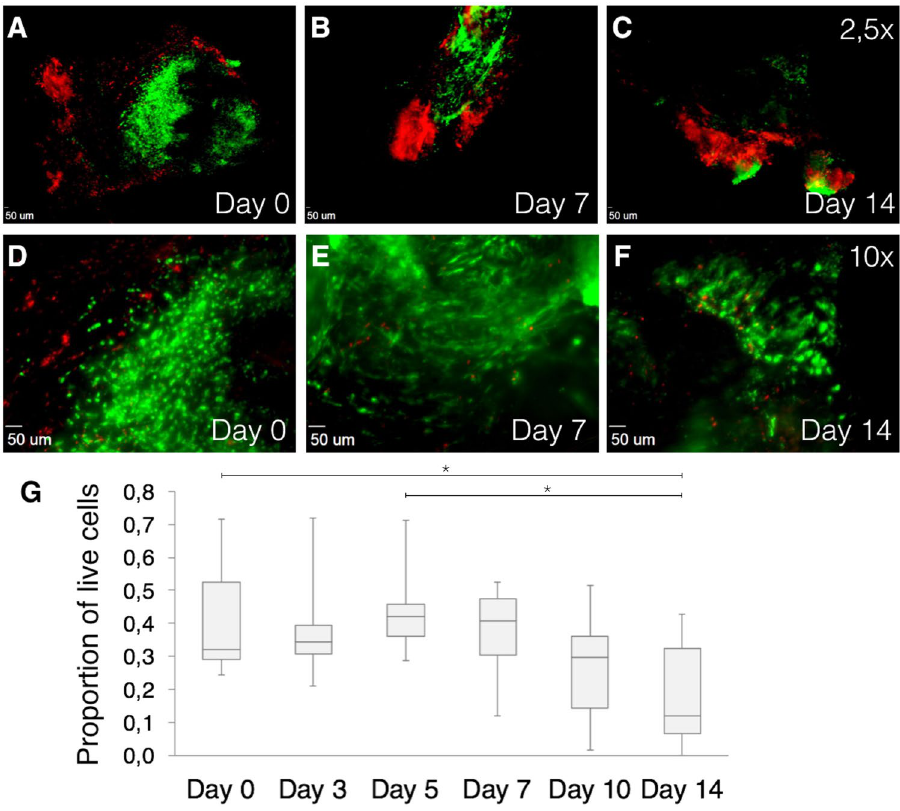
Figure 2. Immunofluorescence images using Zeiss Axiovert 200 M Marianas ™ Microscope. Cells stained with LIVE/DEAD ® Viability/Cytotoxicity Kit. ( A – B ) 2.5 × magnification of cultured tissues at day 0, 7 and 14, respectively. ( D – F ) 10 × magnification of cultured tissues at day 0, 7 and 14, respectively. Green fluorescence shows live cells, while red fluorescence indicates dead nuclei. Live cells are mainly located central to tissue. ( G) Quantification of live human cells in harvested vascular tissues of distinct patients (N = 9). Box plots show proportions of square micron of green fluorescence divided by the sum of green and red fluorescence. * P < 0.05 compared with other time points using ANOVA with Bonferroni